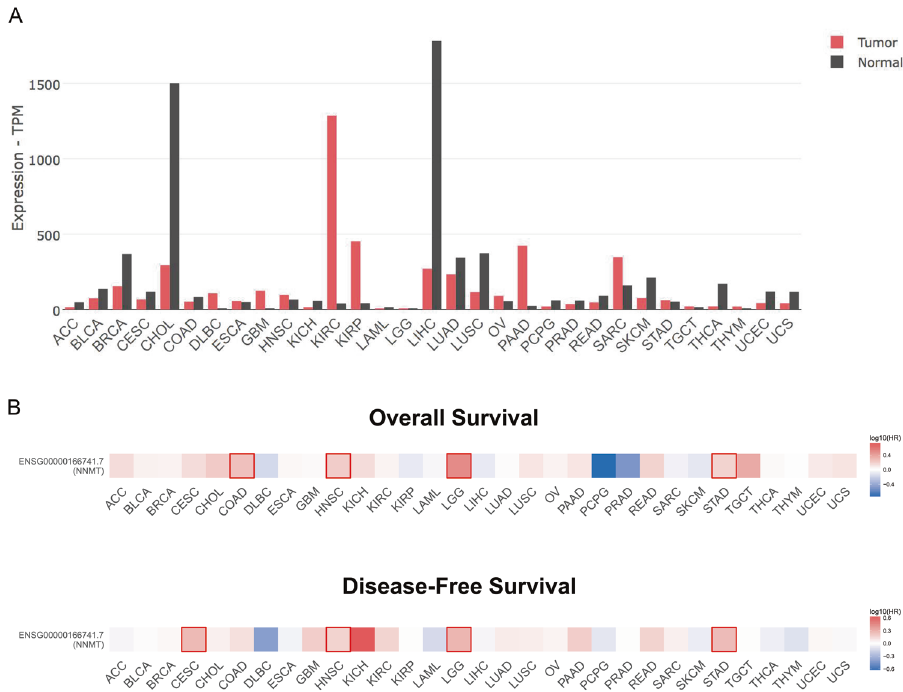
Fig. 4 NNMT expression in different tumor types. Data is processed by GEPIA2 (http://gepia2.cancer-pku.cn/#index), a web server for cancer and normal gene expression pro fi ling and interactive analyses. A The gene expression pro fi le across all 31 types of tumor samples and paired normal tissues. The height of the bar represents the median expression of a certain tumor type or normal tissue. TPM represents transcripts per million. B Survival analysis based on the expression status of NNMT in 31 types of tumors. HR hazard rate, ACC adrenocortical carcinoma, BLCA bladder urothelial carcinoma, BRCA breast invasive carcinoma, CESA cervical squamous cell carcinoma and endocervical adenocarcinoma, CHOL cholangiocarcinoma, COAD colon adenocarcinoma, DLBC lymphoid neoplasm diffuse large B-cell lymphoma, ESCA esophageal carcinoma, GBM glioblastoma multiforme, HNSC head and neck squamous cell carcinoma, KICH kidney chromophobe, KIRC kidney renal clear cell carcinoma, KIRP kidney renal papillary cell carcinoma, LAML acute myeloid leukemia, LGG brain lower grade glioma, LIHC liver hepatocellular carcinoma, LUAD lung adenocarcinoma, LUSC lung squamous cell carcinoma, MESO mesothelioma, OV ovarian serous cystadenocarcinoma, PAAD pancreatic adenocarcinoma, PCPG pheochromocytoma and paraganglioma, PRAD prostate adenocarci- noma, READ rectum adenocarcinoma, SARC sarcoma, SKCM skin cutaneous melanoma, STAD stomach adenocarcinoma, TGCT testicular germ cell tumors, THCA thyroid carcinoma, THYM thymoma, UCEC uterine corpus endometrial carcinoma, UCS uterine carcinosarcoma, UVM uveal